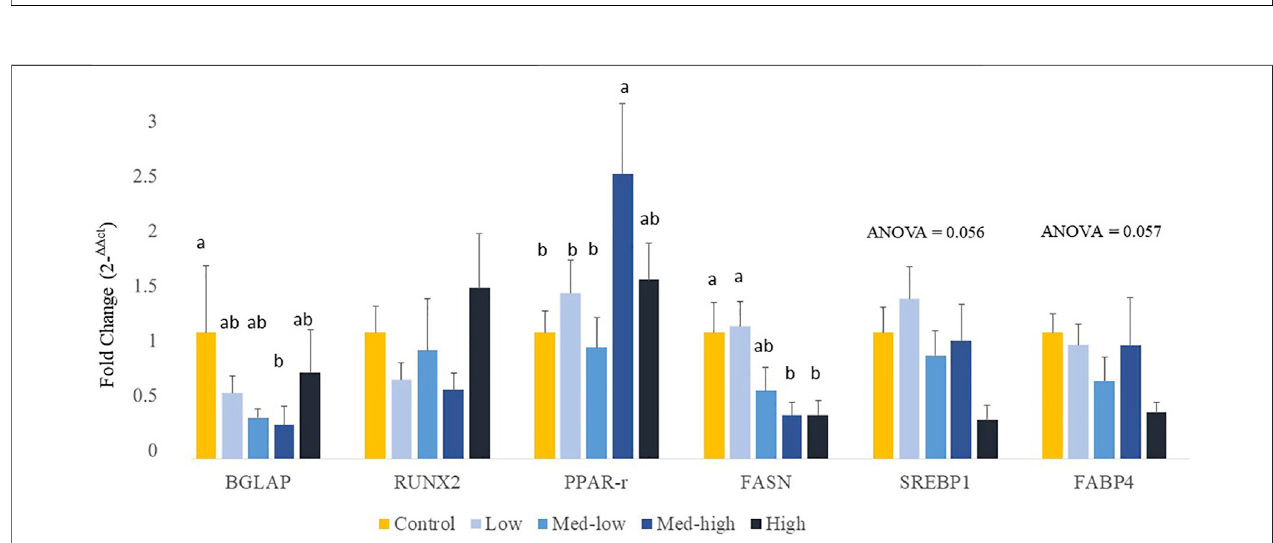
FIGURE 2 | Effects of increasing oocysts dose of Eimeria mix on osteogenesis, adipogenesis and fatty acid synthesis gene expression in bone marrow of broilers. Low, the lowest challenge dose; Med-low, the medium-low challenge dose; Med-high, the medium-high challenge dose; High, the highest challenge dose. BGLAP, bone gamma-carboxyglutamate protein; RUNX2, runt-related transcription factor 2; PPARG, peroxisome proliferator-activated receptor gamma; FASN, fatty acid synthase; SREBP1: sterol regulatory element-binding transcription factor 1; FABP4: adipose tissue fatty acid binding protein 4. a, ab, b Treatments with different letters means a signi fi cantly difference between treatments by using Tukey ’ s HSD test, p < 0.05, N = 6.